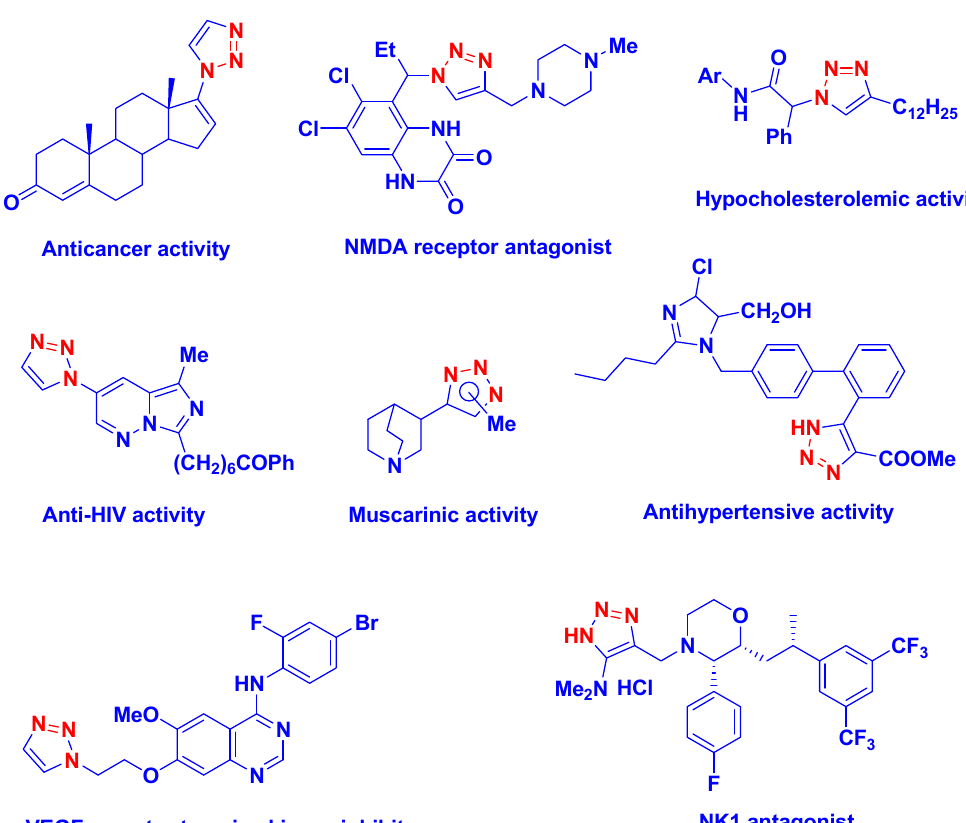
Figure 1. Examples of 1,2,3-trizoles with biological activity.